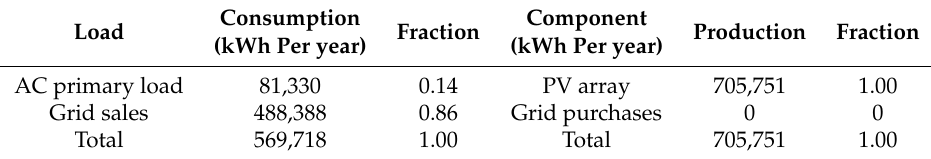
Table 6. Annual electricity consumption and production of the suggested